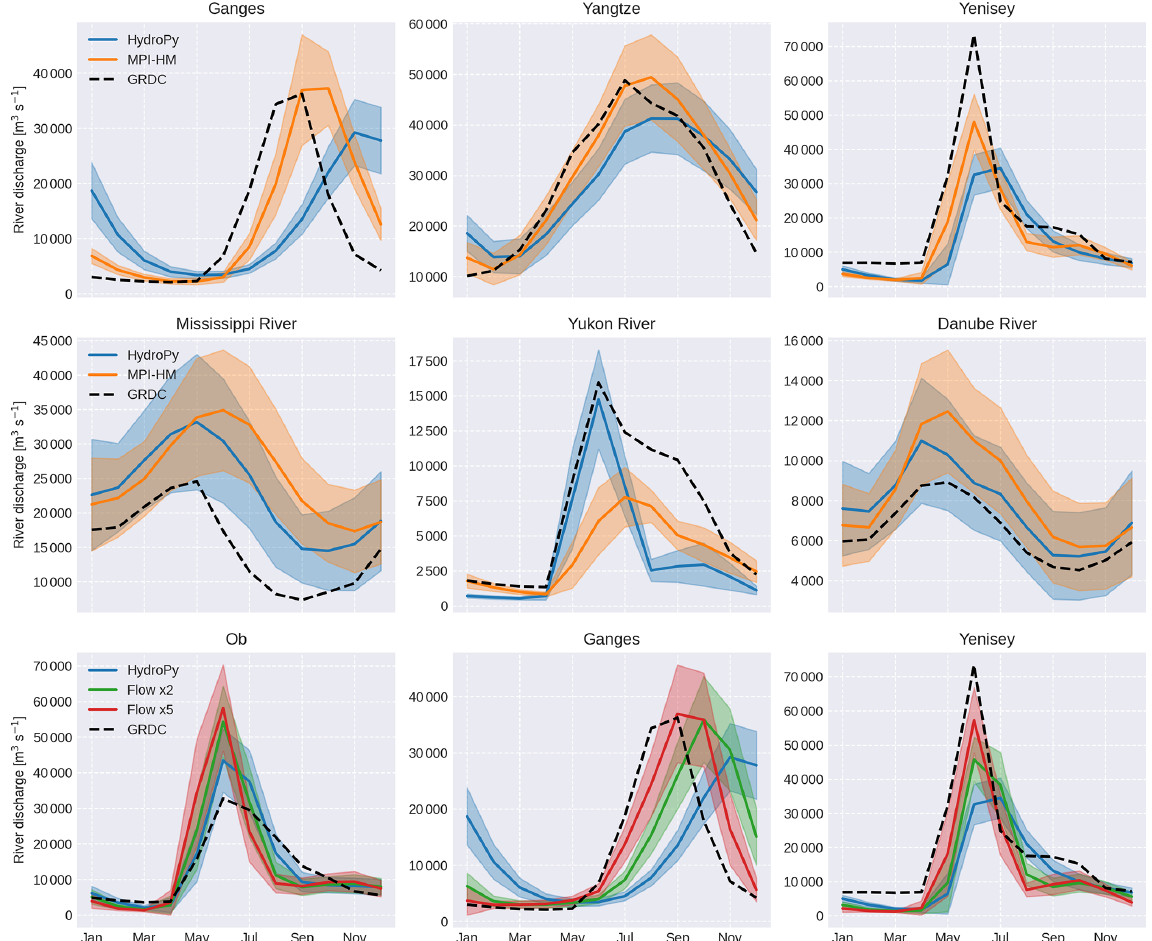
Figure 13. Monthly climatologies of river discharge for different river catchments with GRDC observations (dashed black). The upper two rows also show simulated discharge from HydroPy (blue) and MPI-HM (orange). The lower row shows simulated river discharge produced with the default parameters in HydroPy (blue) as well as those with modified reference flow velocities for wetlands using factors of 2 (green) and 5